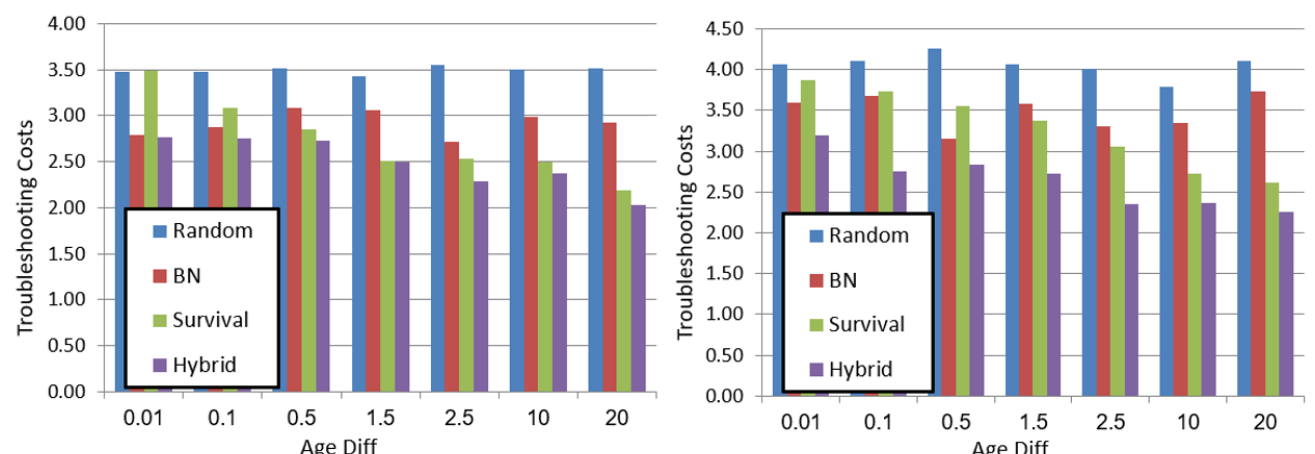
Figure 4. Diagnosis experiments’ results, for S 1 ( left ) and S 2 ( right ). Troubleshooting cost on Age diff